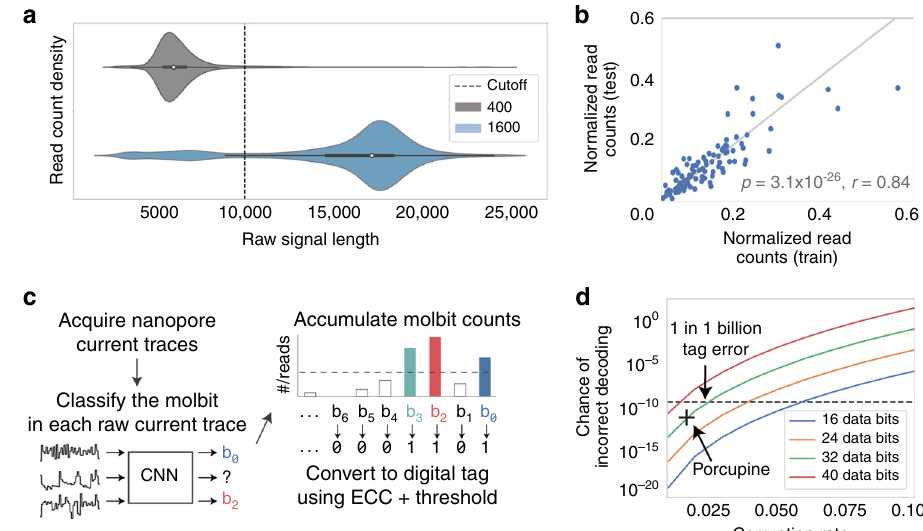
Fig. 3 Molbit classi fi cation and tag decoding results. a Violin plots with embedded box-and-whiskers showing the distribution of raw nanopore signal lengths for DNA sequences of length 400 nt ( n = 354,000 reads) and 1600 nt ( n = 375,000 reads). The white dot represents the median, and the thick center line shows the quartiles. The dashed vertical line shows the cutoff used when calling reads as 400 mers or 1600 mers. b Correlation of read counts for each molbit, demonstrating consistency in molbit occurrences between training and testing runs (two-sided Pearson correlation, p = 3.1 × 10 − 26 , r = 0.84). Counts were fi rst normalized within each run and normalized again after combining runs for either training or testing. c Tag decoding work fl ow, with error correcting codes (ECC). After acquiring nanopore current traces from a standard sequencing run, the molbit in each trace is identi fi ed using the CNN (con fi dence ≥ 0.9). Successfully identi fi ed molbits are accumulated and converted into binary using a threshold for presence. This threshold is varied as error correction is carried out multiple times, accepting the binary digital tag that has the fewest differences from the received codeword. d Chance of incorrect tag decoding as a function of the bit corruption rate and number of data bits. This chance increases exponentially as the corruption rate and number of data bits increase linearly. The dashed line represents the goal of 1 in 1 billion tags incorrect, and the “ + ” marks Porcupine ’ s chance of incorrect decoding. Source data are provided as a Source Data fi